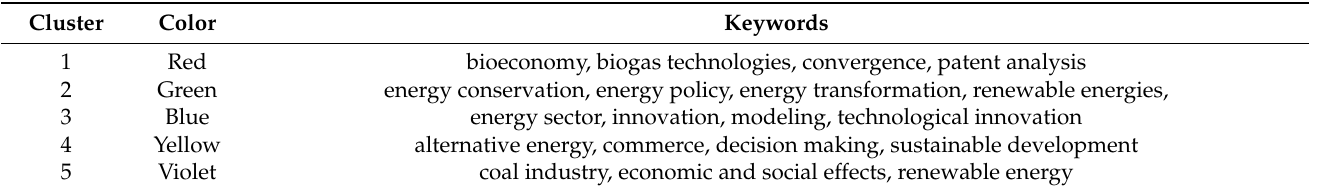
Table 6. Clusters of all keyword co-occurrences in Figure 6 for